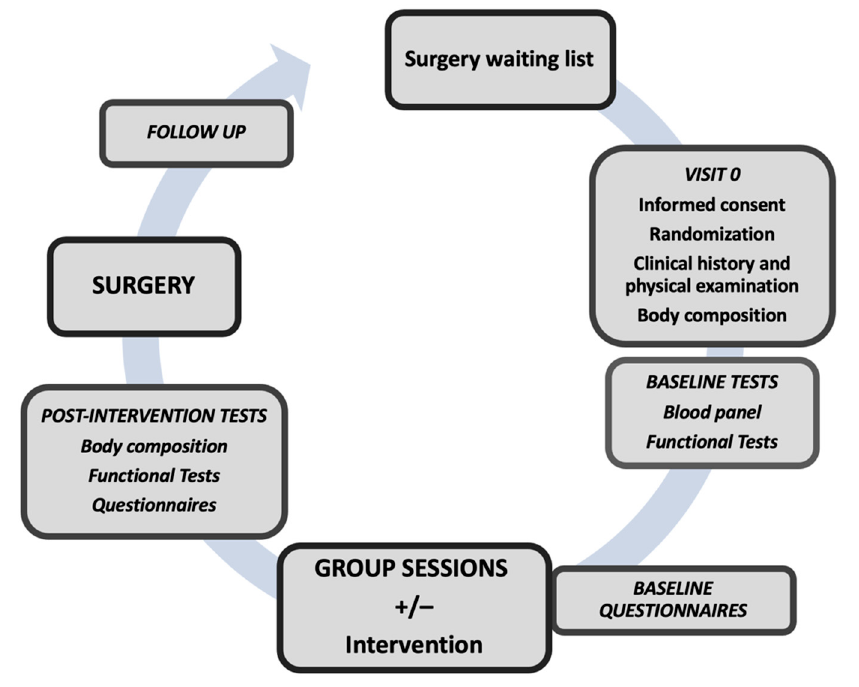
Figure 1. Study flow chart.